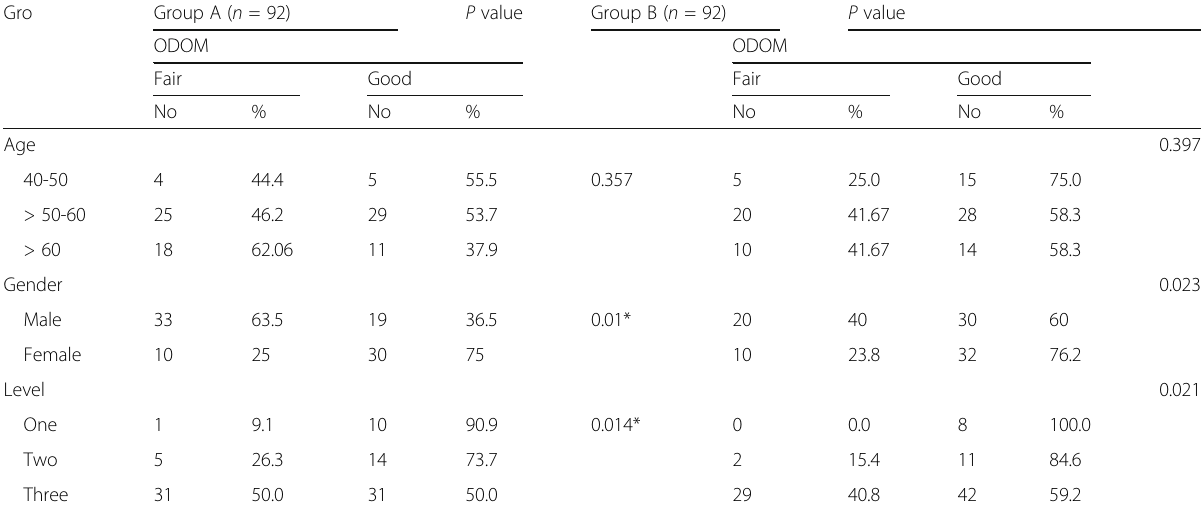
Table 2 Patients satisfaction of surgery regarding ODOM in different ages and level of both groups Gro Group A ( n =